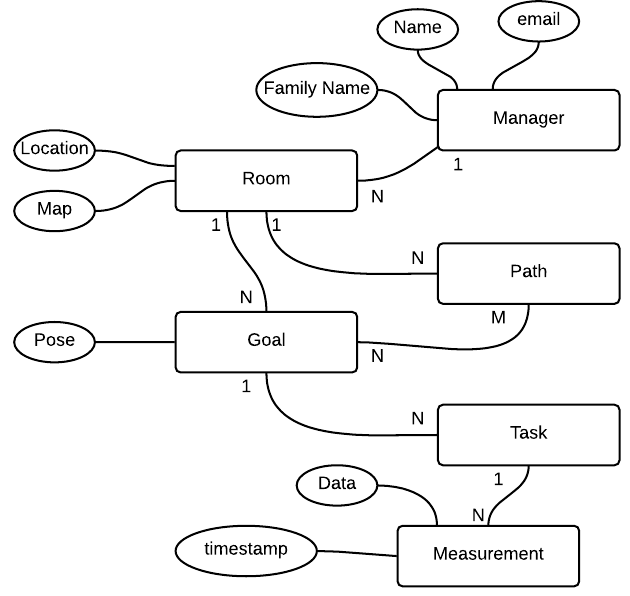
Figure 4. The database structure used in the proposed system. Rectangles represent tables, and ellipses represent data associated with each table. 1:N and M:N represent respectively one-to-many and many-to-many